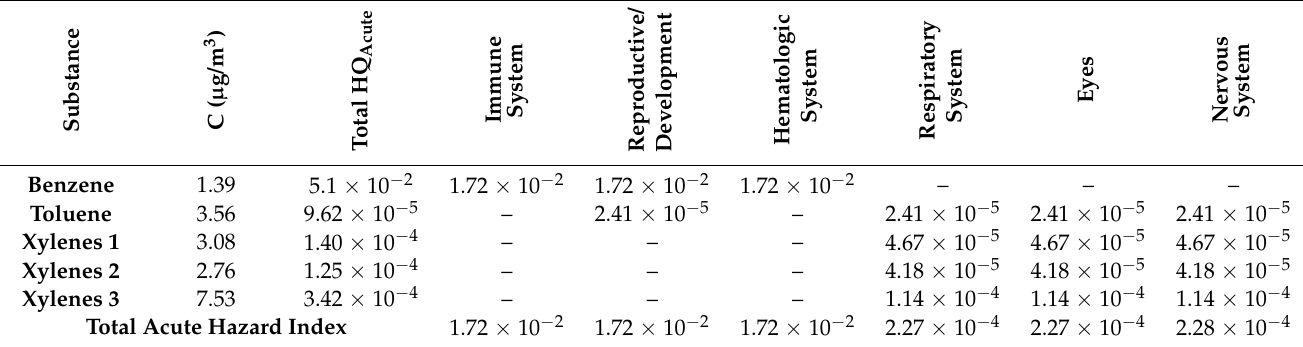
Table 7. HQ for each Target organ System(s) & Acute HI (OEHHA, 2015).